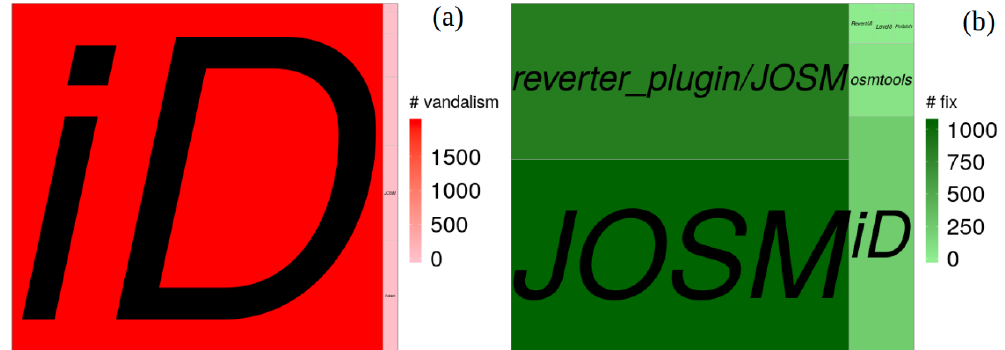
Figure 9. Choice of editor software for ( a ) PGO vandalism and ( b ) vandalism fixing. Table 2. Number of map features affected by PGO vandalism.